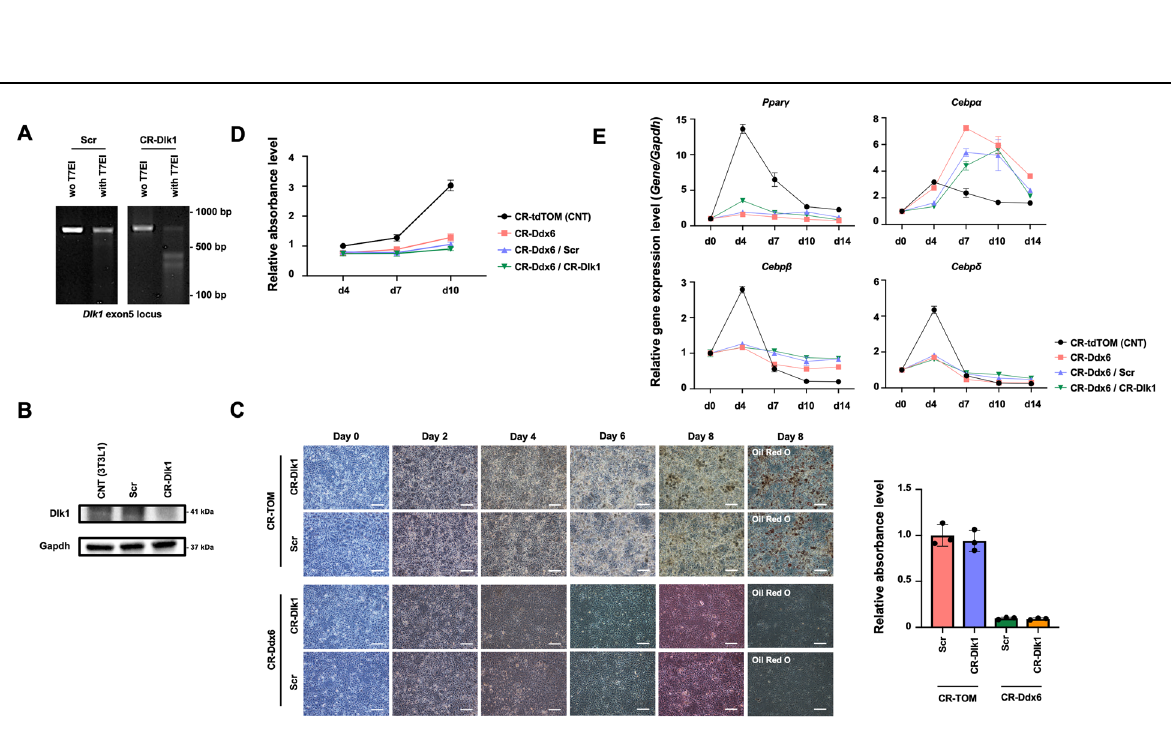
Fig. 6 Adipogenic differentiation of 3T3L1 Dlk1-KO preadipocytes. A T7EI mismatch detection assay for assessment of the ef fi ciency of the CRISPR-Cas9 system. B Western blot veri fi cation of Dlk1 KO by the CRISPR-Cas9 system. C Phase-contrast microscopy images during adipogenesis and the relative absorbance of oil red O on day 8. The scale bar is 100 μ m. The error bars indicate the SDs ( n = 3). D Relative absorbance of oil red O on each day. The error bars indicate the SDs ( n = 3). E RT-qPCR analysis of the expression of each gene during adipogenesis. Individual RNA expression levels were normalized to Gapdh expression levels. The error bars indicate the SDs ( n =